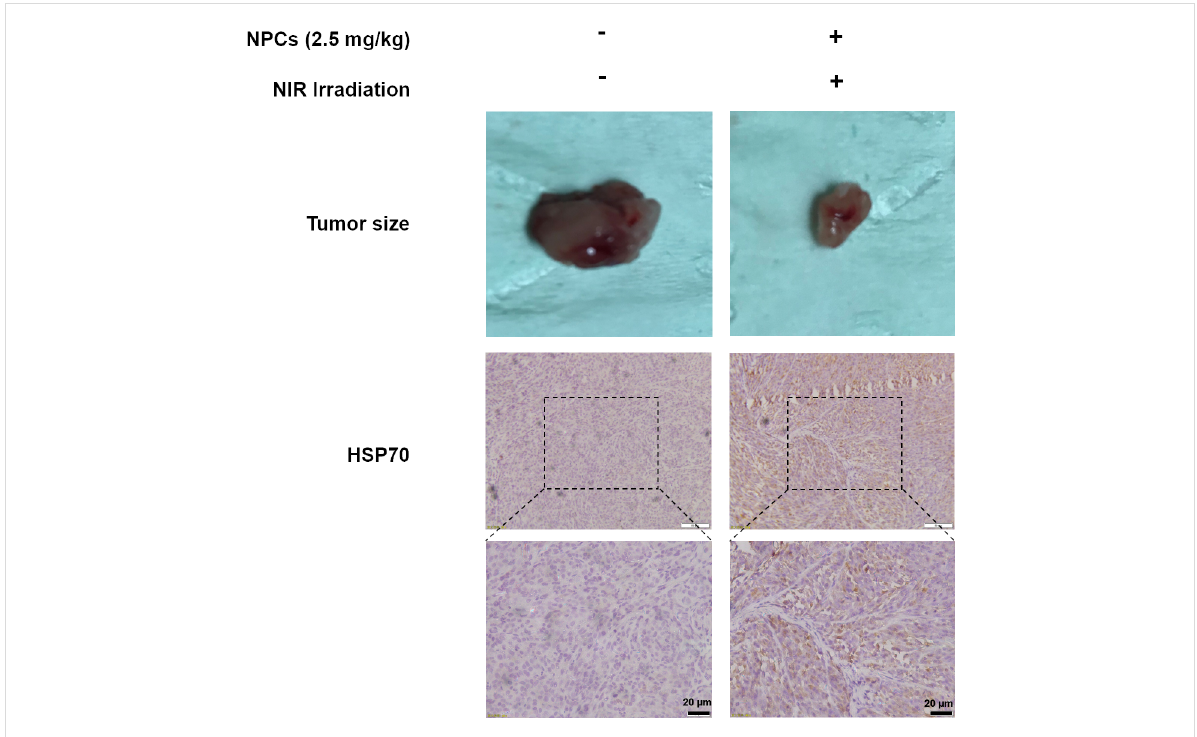
Figure 5: Photothermal therapy increases tumoral level of HSP70. Tumors were isolated from mice that received intratumor injection of either saline without NIR exposure or NPCs (2.5 mg/kg) followed by NIR irradiation. Immunohistochemical staining of harvested tumors revealed HSP70 to be elevated (brown signals) by PTT.